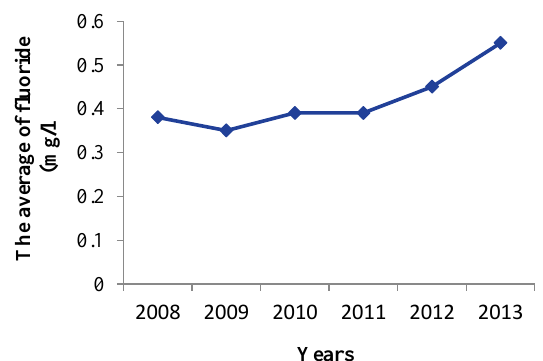
Figure 2. The average of fluoride (mg/l) by year 2008-2013